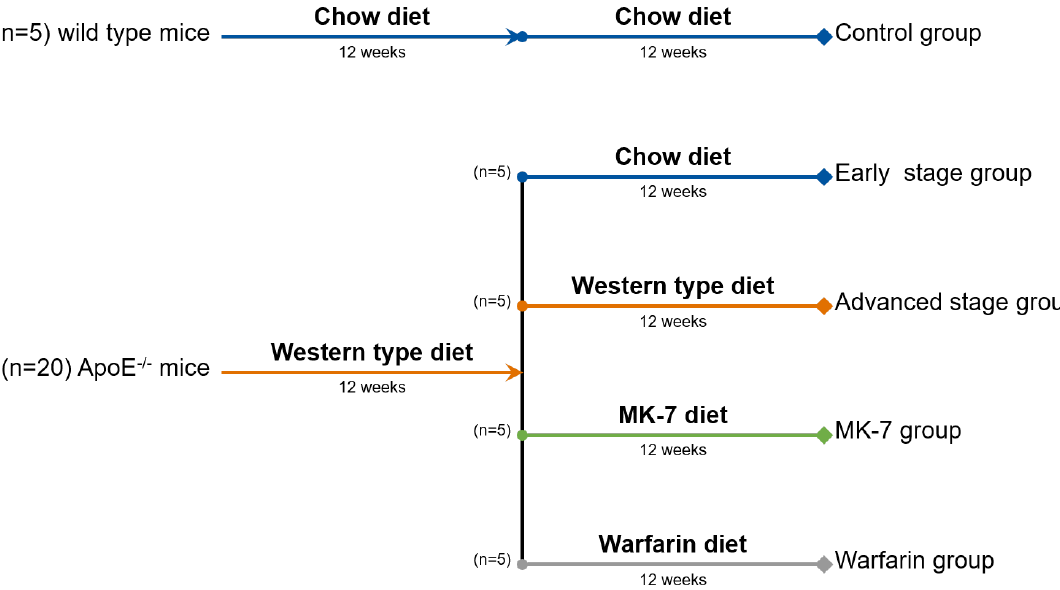
Figure 1. Feeding scheme: 20 ApoE − / − mice started a Western-type diet for 12 weeks, in order to develop early stage plaque. At the end of the 12 weeks, 5 mice were switched to a regular chow feed (early stage group), 5 mice continued their Western type diet for the additional 12 weeks (advanced stage group), 5 mice were switched to a vitamin K deficient chow feed supplemented with MK-7 (100 μg/g of feed; MK-7 group), and the remaining 5 mice were switched to a vitamin K deficient chow supplemented with Warfarin (3 mg/g of feed) and Phylloquinone (1.5 mg/g of feed) for an additional 12 weeks (Warfarin group).